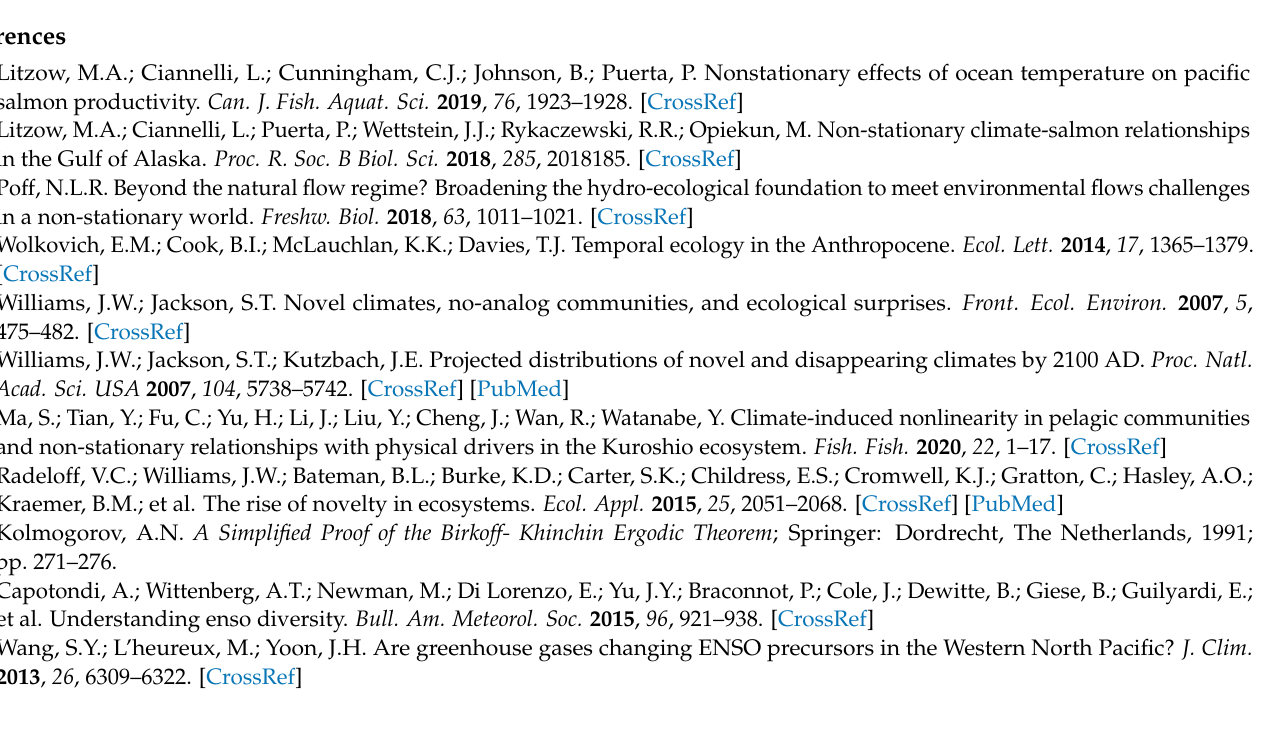
Model. Figure S1. Maps of correlation coefficients between the shared trend out from the Bayesian DFA and monthly sea surface temperature (SST) fields. Purple dotted lines enclose area with significant correlations ( p < 0.05). Figure S2. Maps of correlation coefficients between the time series of mean bottom water temperature (depth = 317m, 1956–2010) and winter(NDJFM) sea surface temperature (SST) field. Purple dotted lines enclose area with significant correlations ( p < 0.05). Black dotted lines enclose area with high correlations ( r > 0.7). Figure S3. EOF analysis for winter (NDJFM) SST field in temperate waters of the NWP: The leading spatial pattern (eigen vector) (left) and the time series of SST PC1 (right). Figure S4. The time series of normalized mega-ENSO index (1956–2015). Figure S5. Maps of DJF sea surface temperature (SST) normalized anomalies in mega- El Niño (left) and mega- La Niña (right) during era2 (1987–2015). Figure S6. Non-stationary temporal relationships between NPGO and winter SST: (a) era-specific posteriors distribution for the slope and intercept of NPGO on winter SST PC1. (b) era-specific Scatter plots and best linear fits with corresponding R2 and p values to NPGO and winter SST PC1 estimated by Bayesian regression models. Figure S7. Time series data of demersal fishes